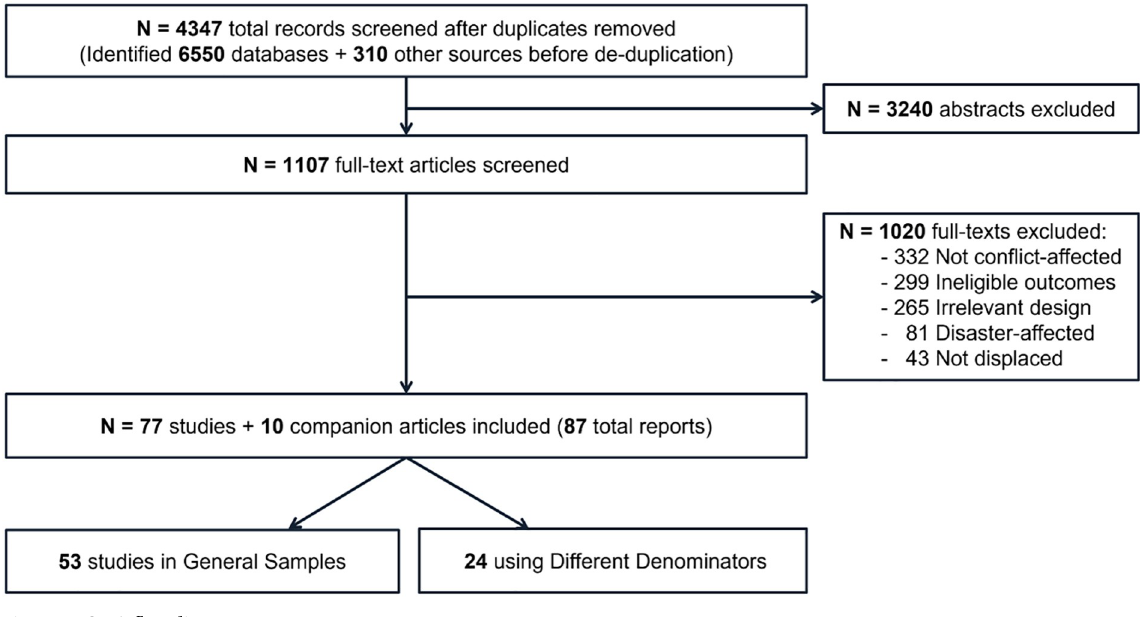
Fig 1. PRISMA flow